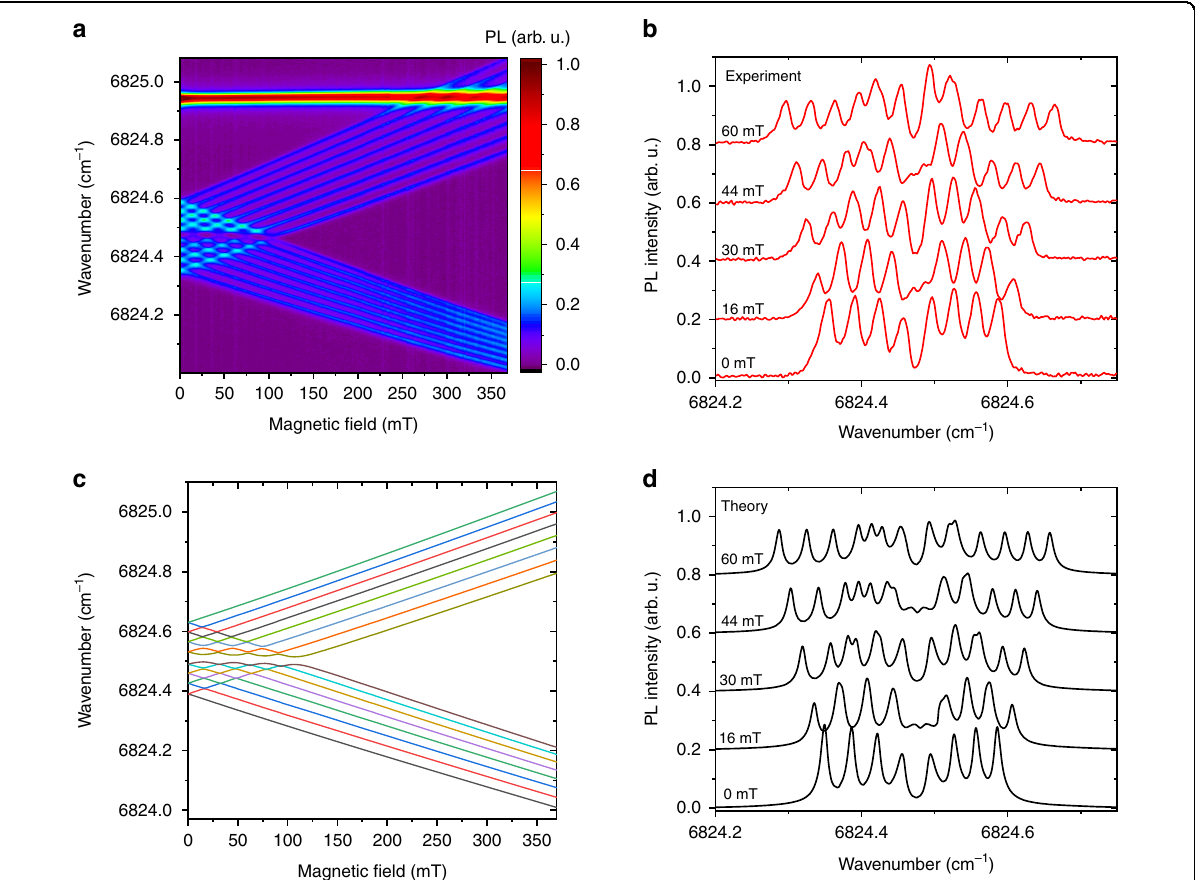
Fig. 7 The 5 F 5 Г 34 (15,495.4) level demonstrates the largest deformation splitting. a Luminescence intensity map in the magnetic- fi eld – wavenumber scale and b calculated frequency vs magnetic fi eld dependences for the 5 F 5 Г 34 (15495.4) → 5 I 6 Г 2 (8670.9) transition in 7 LiYF 4 :Ho 3 + (0.1 at. %) at 10 K . c Experimental and d calculated spectra of this transitions at several values of the magnetic fi eld. A strong horizontal line in a corresponds to the singlet – singlet transition 5 F 5 Г 1 (15,512.7) → 5 I 6 Г 2